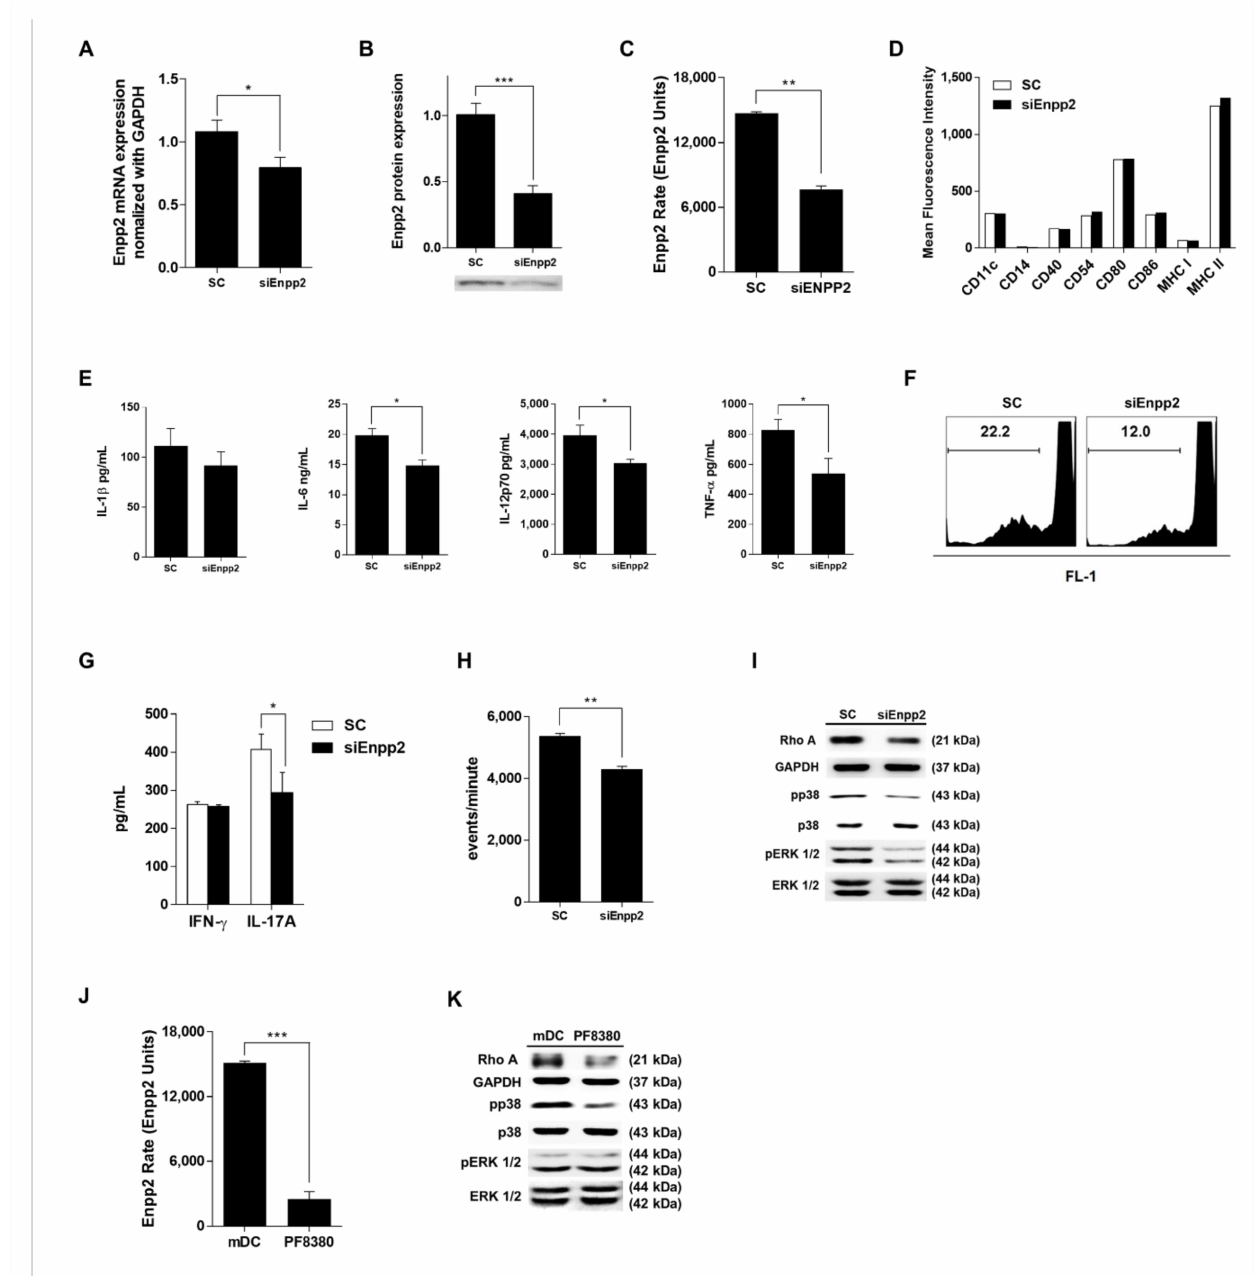
Figure 2. Enpp2 knockdown in mDCs affects their immunogenicity. ( A ) Expression of Enpp2 mRNA in DC subsets (scramble siRNA-treated mDCs; SC, and Enpp2 siRNA-treated mDCs; siEnpp2). Enpp2 expression was measured by qRT-PCR. Values were normalized against GAPDH expression. The bar graph shows the Enpp2 expression relative to levels in imDCs. Data are presented as mean ± SEM ( n = 5 independent DC preparations). ( B ) Levels of secreted Enpp2 protein in concentrated (20-fold) conditioned low serum medium from SC or siEnpp2 were detected by Western blotting. Data in the bar graphs were obtained by densitometric analysis of Western blots. All data are expressed as the mean ± SEM ( n = 3 independent experiments). ( C ) Fluorescence assay of Enpp2 activity. Enzyme activity in conditioned medium was measured for over 2 h. The bar graph shows the Enpp2 activity rates, expressed as the mean ± SEM ( n = 3 independent DC preparations). ( D ) SC and siEnpp2 were stained with the indicated fluorescent-labeled antibodies and analyzed by flow cytometry. The bar graphs show the mean fluorescence intensity (MFI). ( E ) Pro-inflammatory cytokines in culture supernatants from DCs